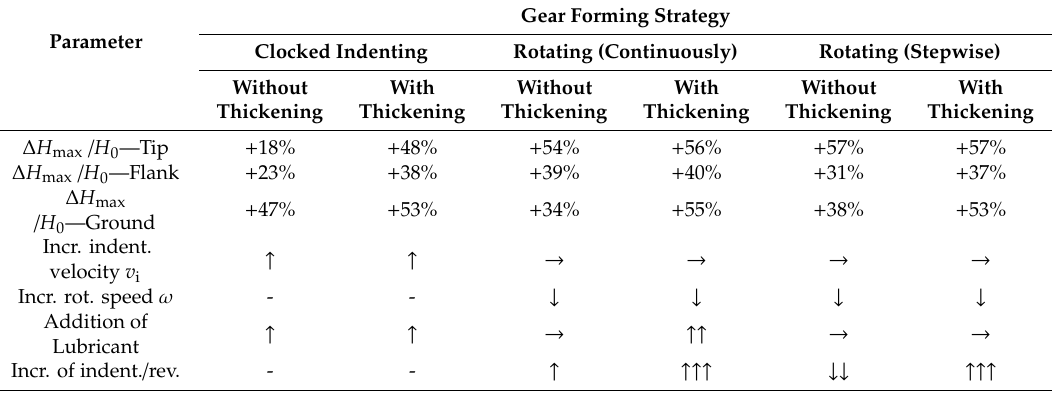
Table 4. Impact of process parameters and gear forming strategies on the hardness of the gears made of BS600